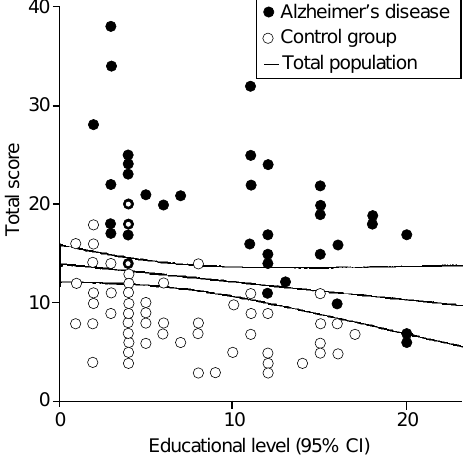
Figure 1. Performance in total score of the cognitive subscale of the "Alzheimer's Disease As- sessment Scale" for years of educational level. CI,